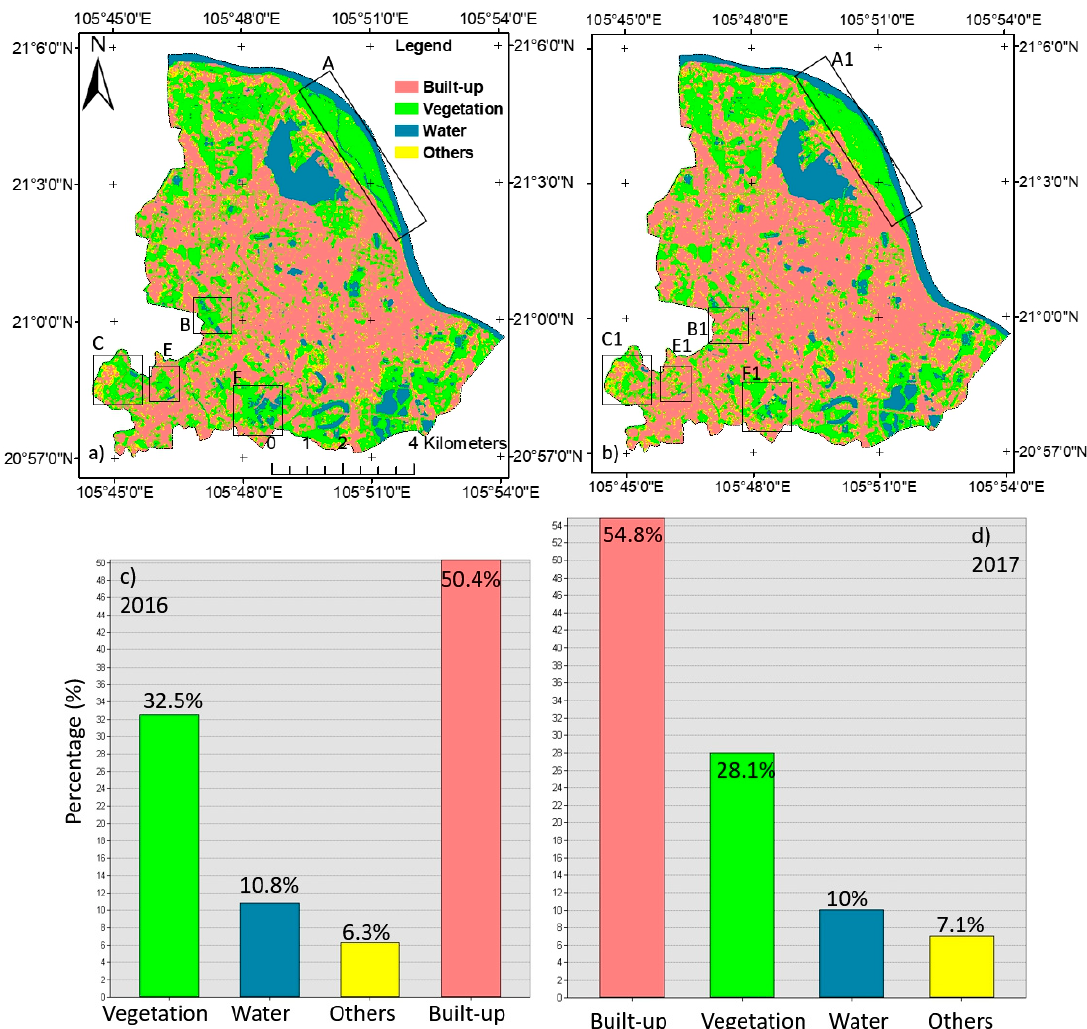
Figure 4. Land-use maps of inner Hanoi city for ( a ) 1 June 2016, and ( b ) 4 June 2017. Areas with substantial land-use changes are visually chosen and labeled as A, B, C, E, and F in ( c ) and ( d ) with coverage percentage statistics for the three major land-use types of concern and others in the years 2016 and 2017, respectively.